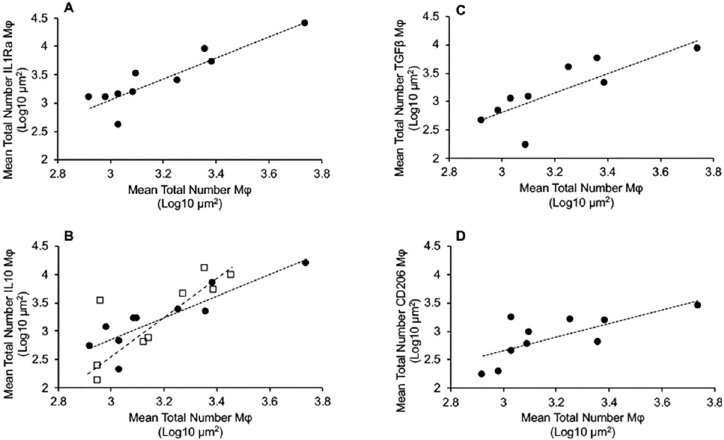
Fig 6. Pairwise Pearson correlations for total number of macrophages (M φ ) with resolution and repair M φ phenotypes. ( A ) correlation between total M φ and number of IL-1Ra+ M φ for subclinical cows; ( B ) correlation between total M φ and number of IL-10+ M φ for subclinical cows ( ● and dotted line) and clinical cows ( □ and dotted line); ( C ) correlation between total M φ and number of TGF- β + M φ for subclinical cows; and ( D ) correlation between total M φ and number of CD206+ M φ for subclinical